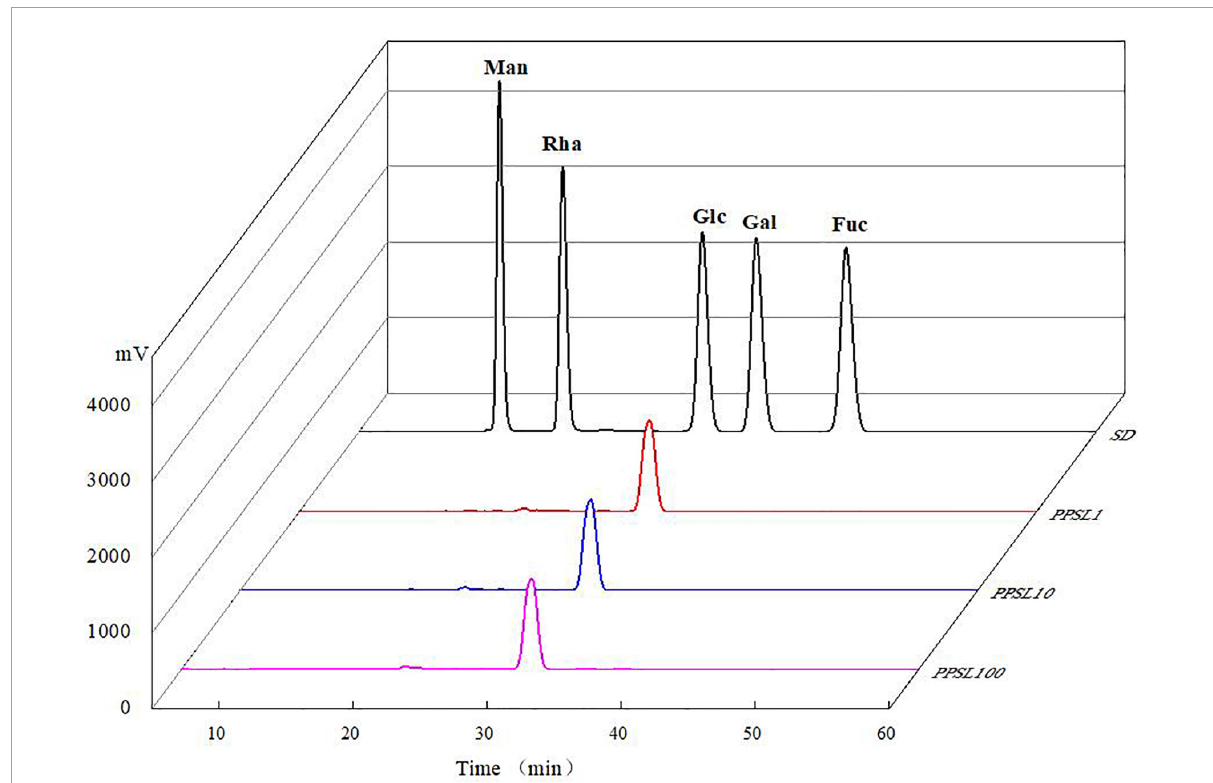
FIGURE2 Monosaccharide compositions of mixed standards, PPSL1, PPSL10, and